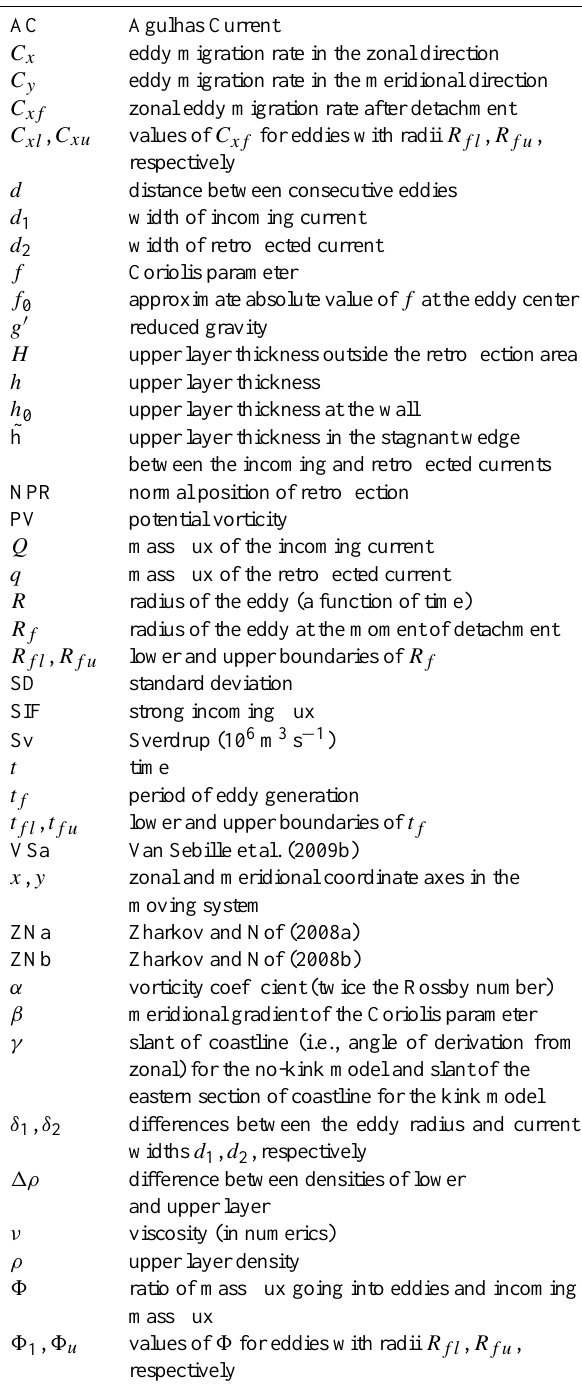
Table A1. List of